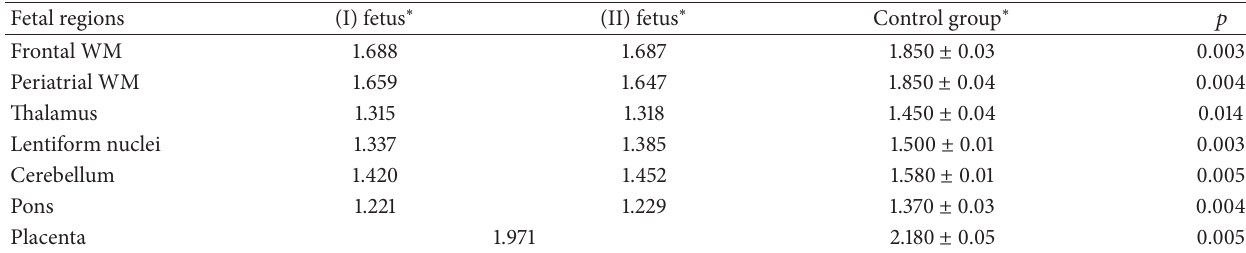
Table 1: Fetal brain and placenta ADC values (mm 2